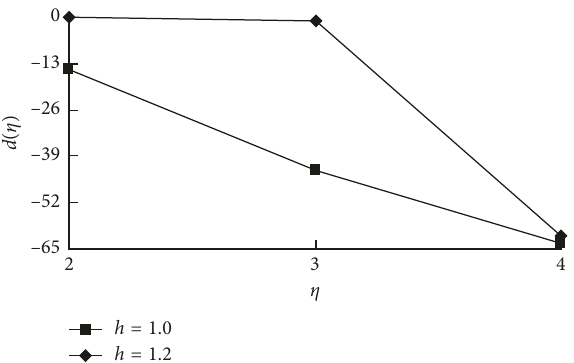
Figure 14: Accuracy maintaining the relative reliability for superprecision rolling